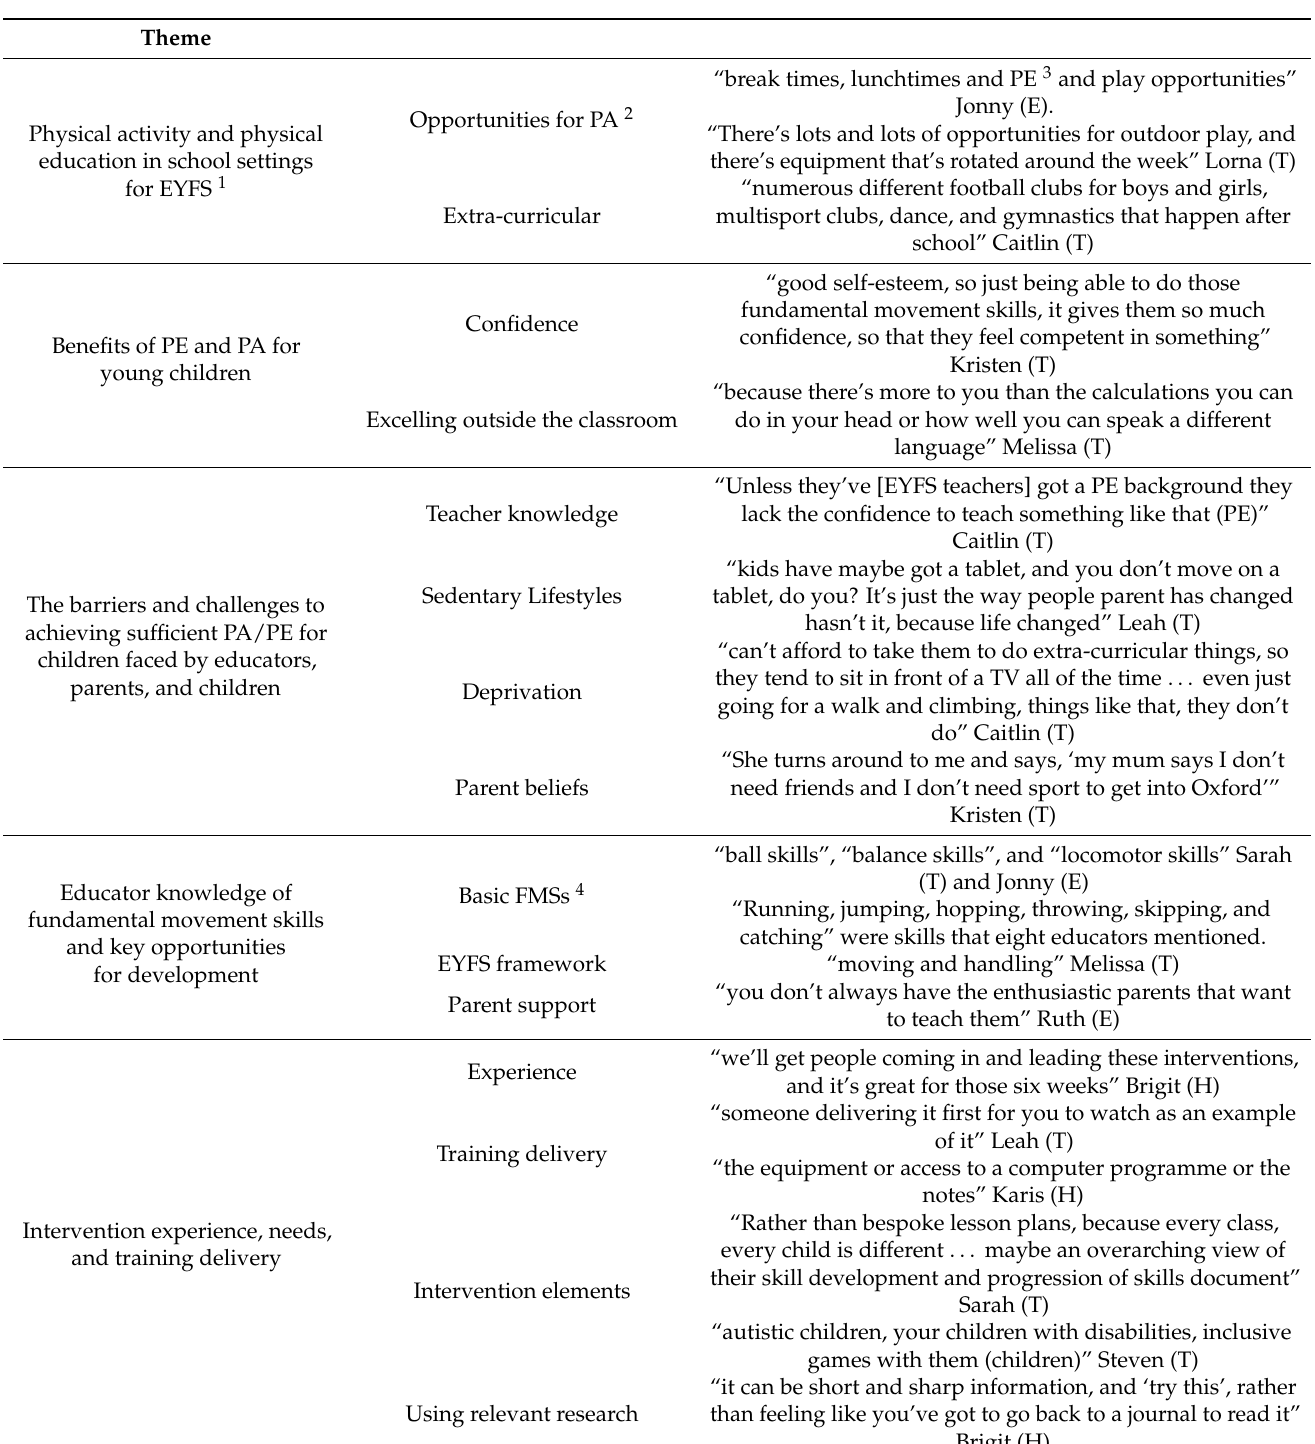
Table 1. Summary of themes and key